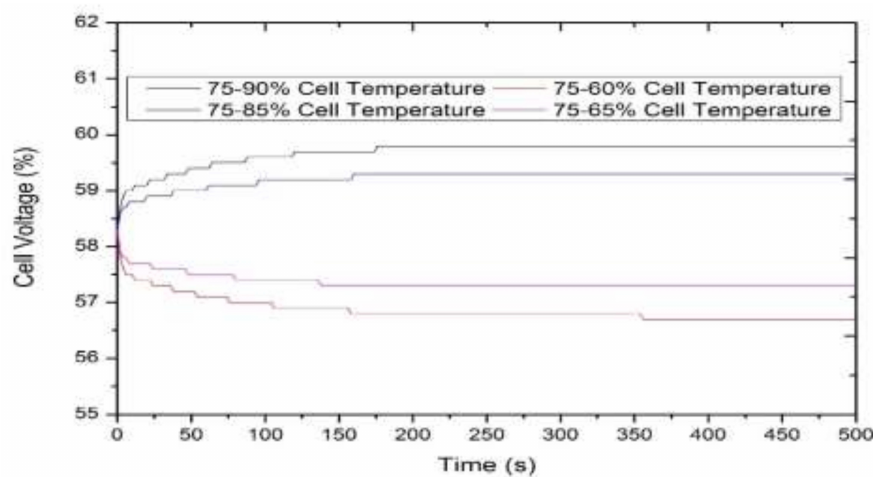
Figure 8. Step response of DMFC at 75% of the operating temperature.